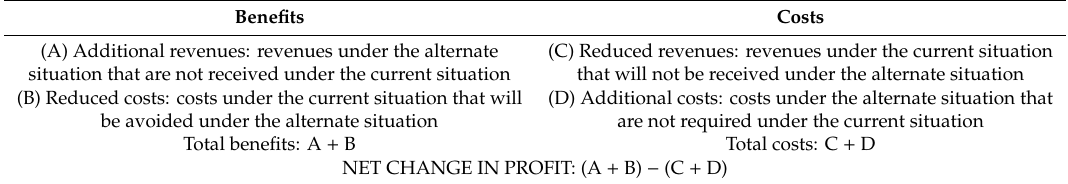
Table 3. Partial budgeting layout comparing current situation versus alternate